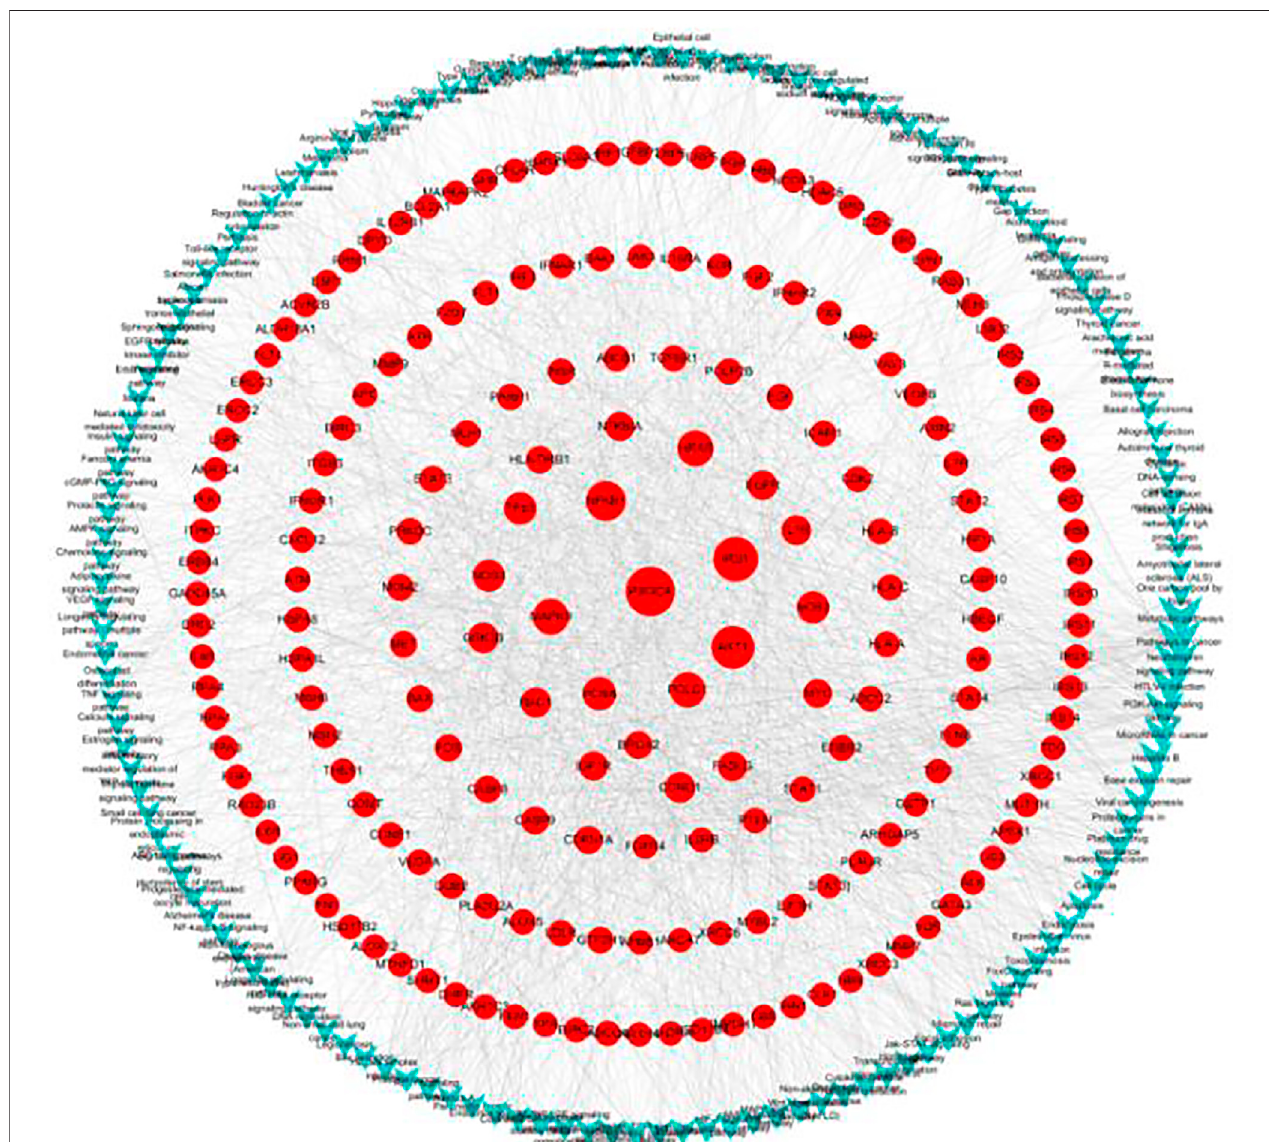
FIGURE 6 | Gene-pathway network for G-Rh2 in lung cancer. Red circles, target genes; blue V-shapes, pathways. Size is proportional to betweenness centrality.